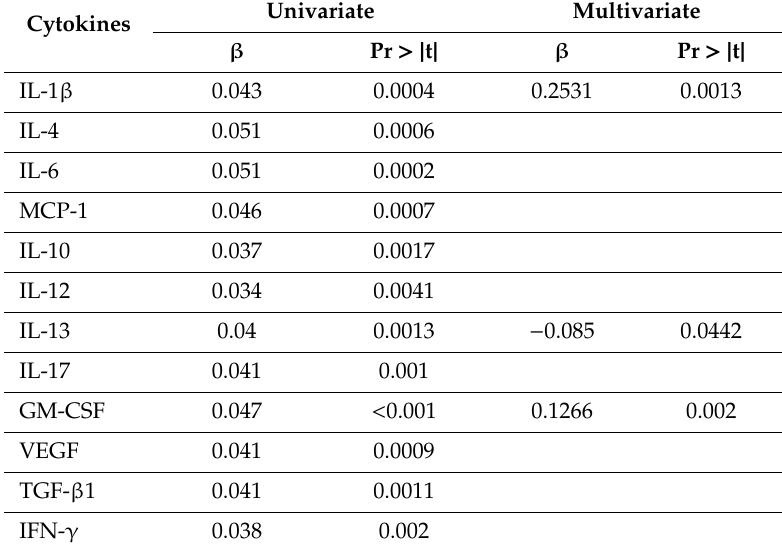
Table 4. Linear regression estimates for EORTC QLQ-C30 with selected